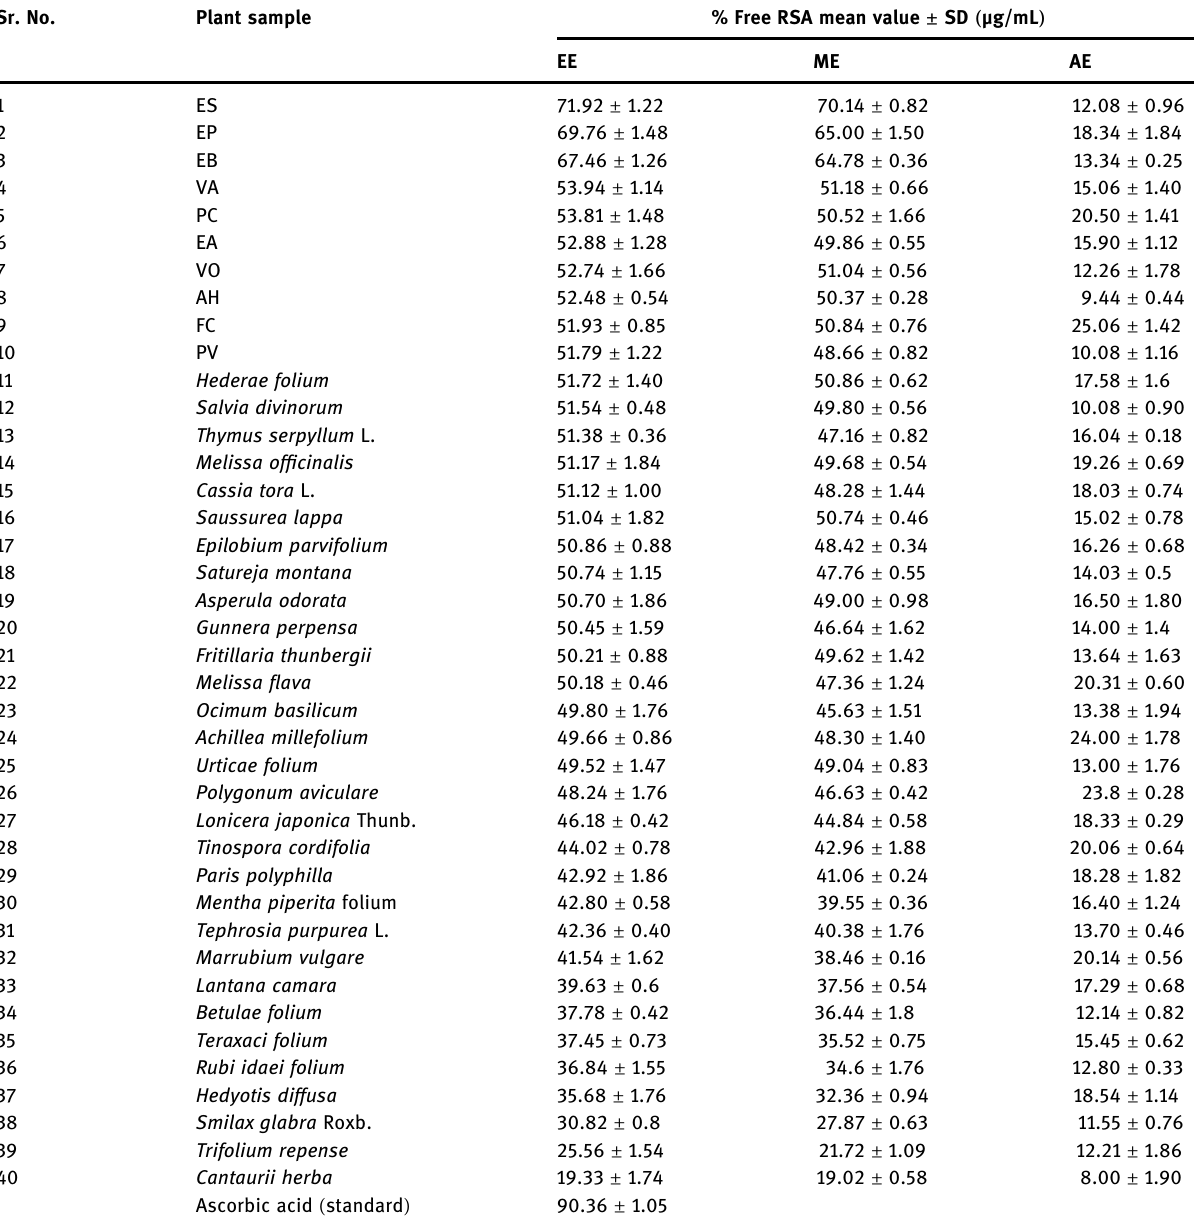
Table 5: The inhibitory e ff ects of various medicinal plant extracts in DPPH assay at 517 nm Sr.